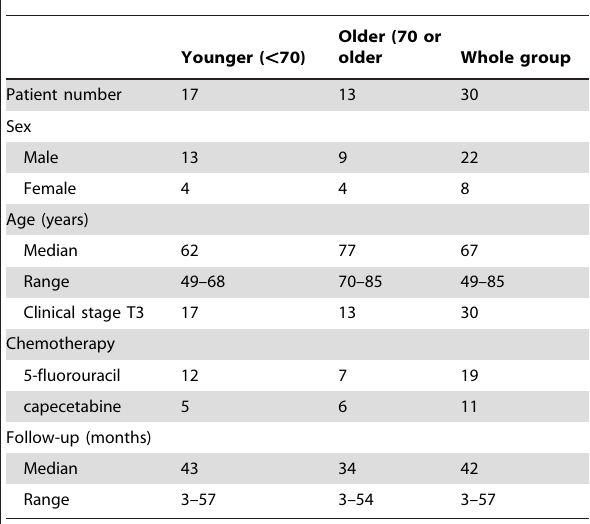
Table 1. Patient